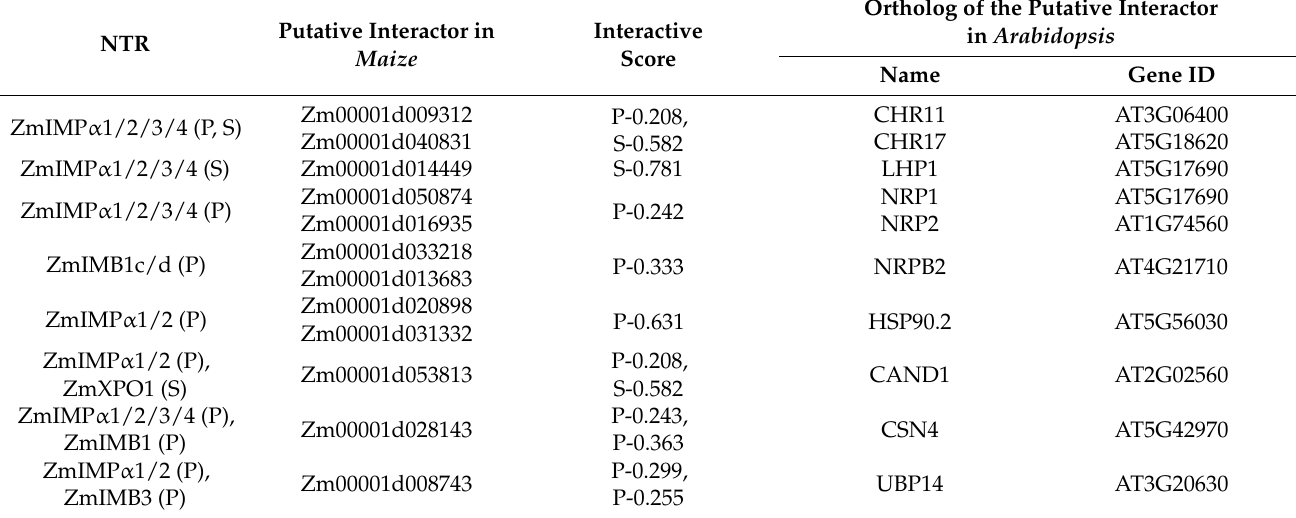
Table 3. Predicted interacting protein of the